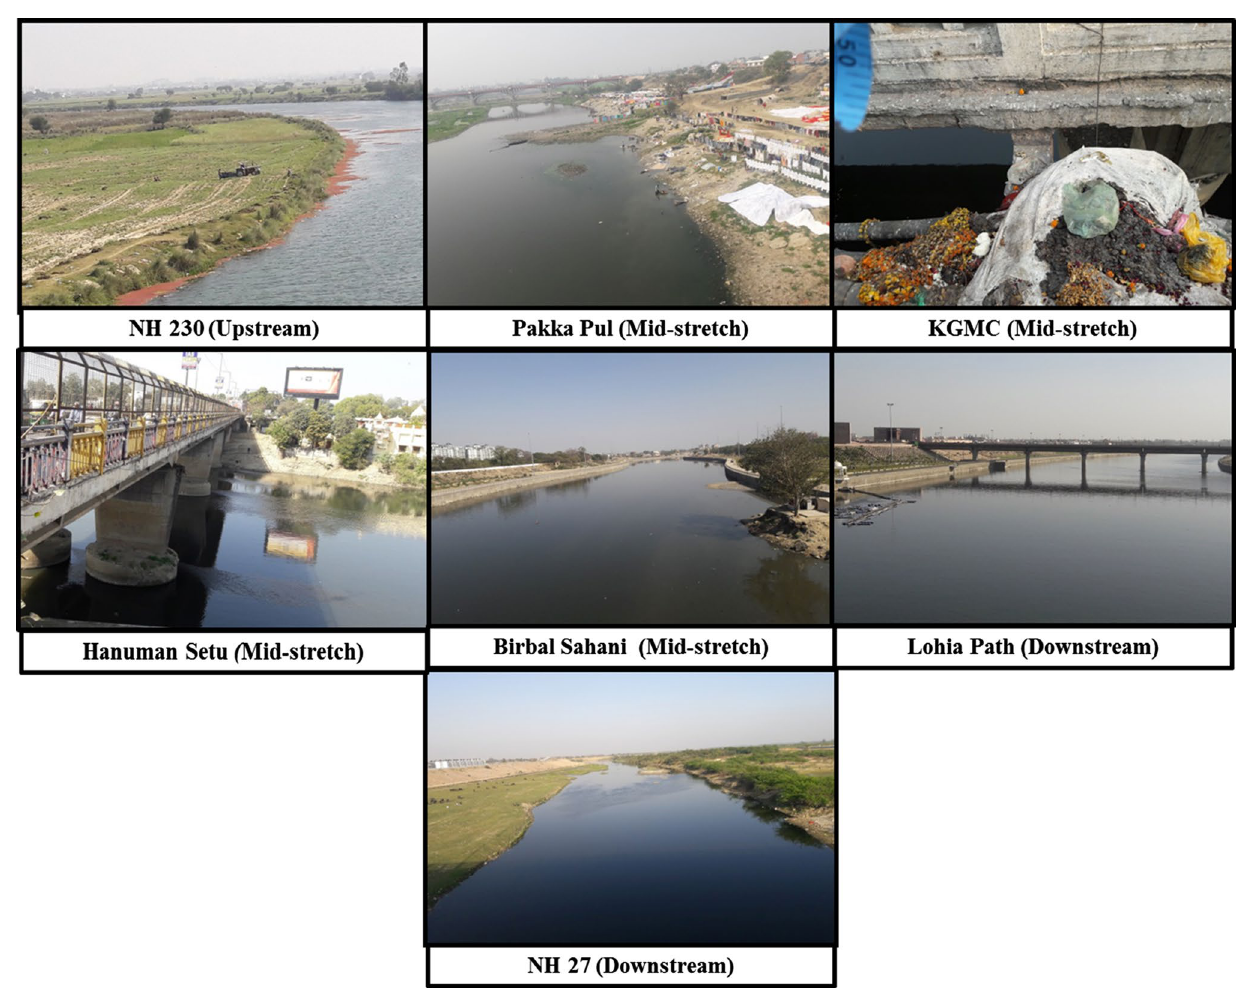
Fig. 2 Sampling sites of Gomti River in Lucknow